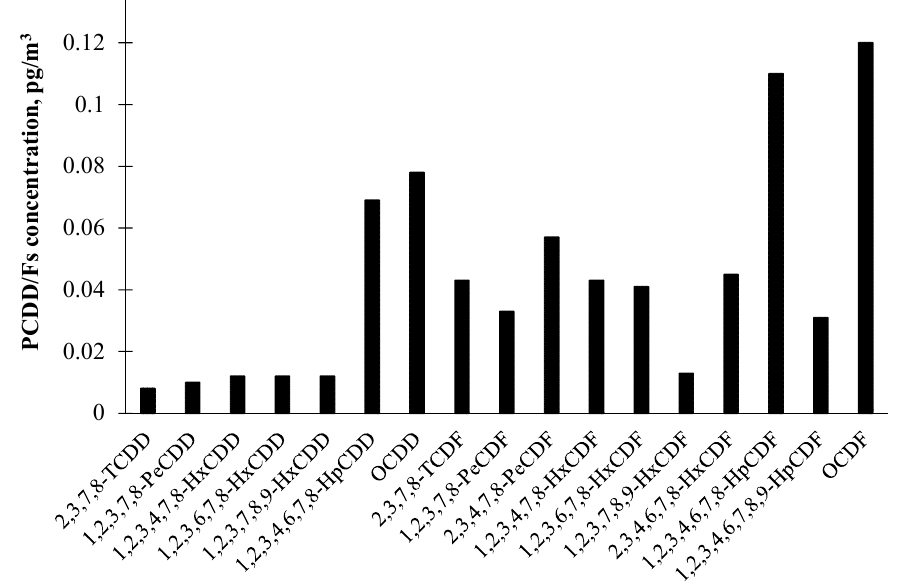
Figure 7. Maximum of PCDD / F congeners concentration in Vilnius (February 2018).